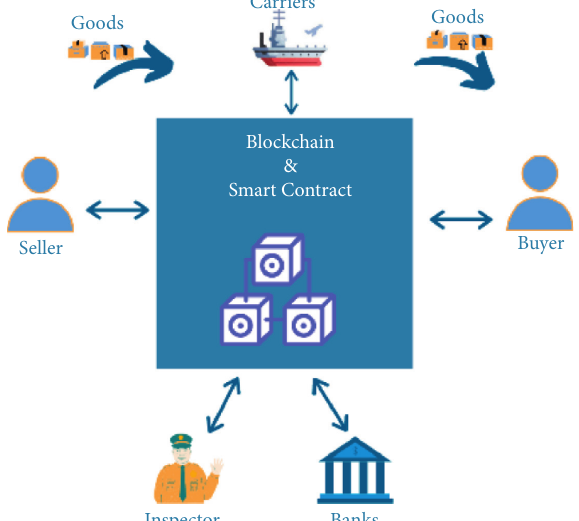
Figure 1: Trade credit consolidation through Blockchain